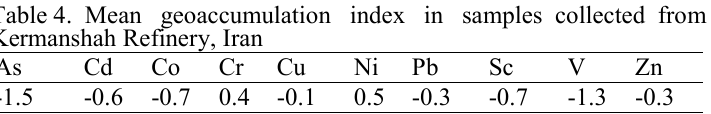
Table 4. Mean geoaccumulation index in samples collected from Kermanshah Refinery, Iran